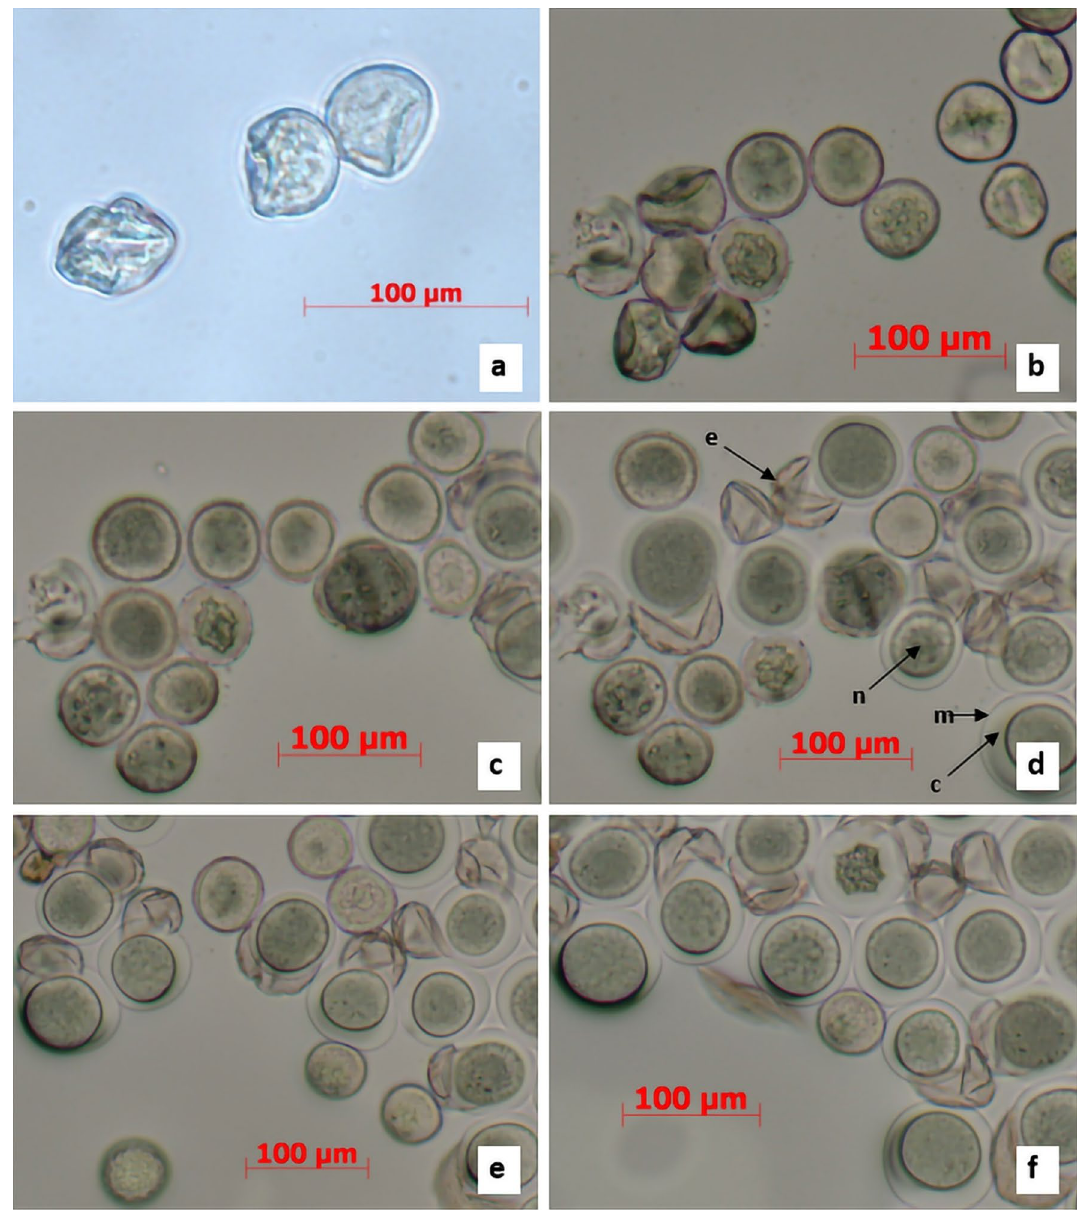
Figure 3. Dynamics of pollen hydrophilic capsule formation in pollen grains immediately after sowing on media ( a ) and subsequent changes after 10 ( b ), 50 ( c ), 55 ( d ), 60 ( e ), and 90 min ( f ) of cultivation; e-exine, m -hydrophilic capsule membrane, n-pollen nucleus, c-hydrophilic capsule. The photos were taken using Axioplan 2 microscope with built in AxioVision 4 software (Carl Zeiss Vision Gmb